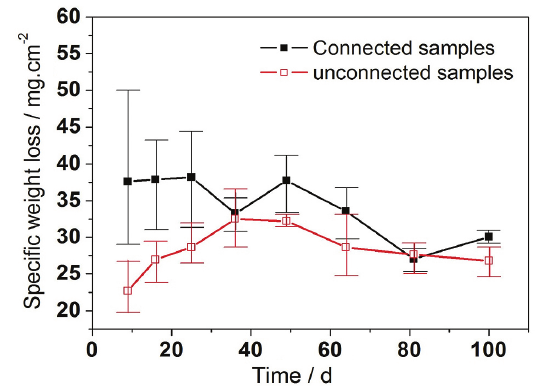
Figure 5. Specific weight loss per attacked area versus exposure time.